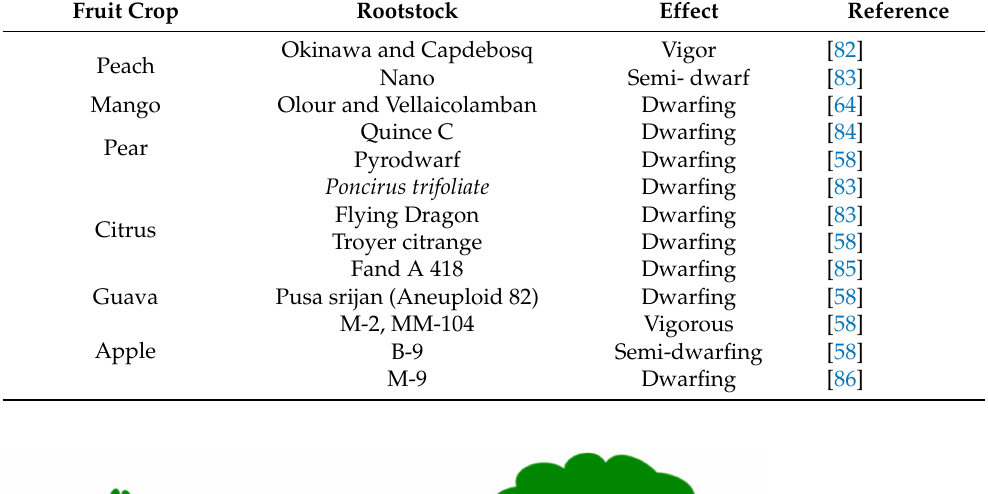
Table 3. Details of rootstocks effect on tree vigor in various fruit crops.